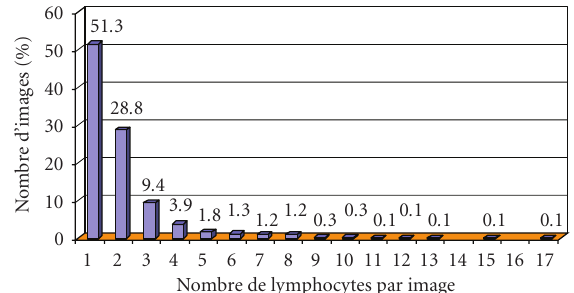
Figure 3: Distribution of the number of lymphocytes per image.